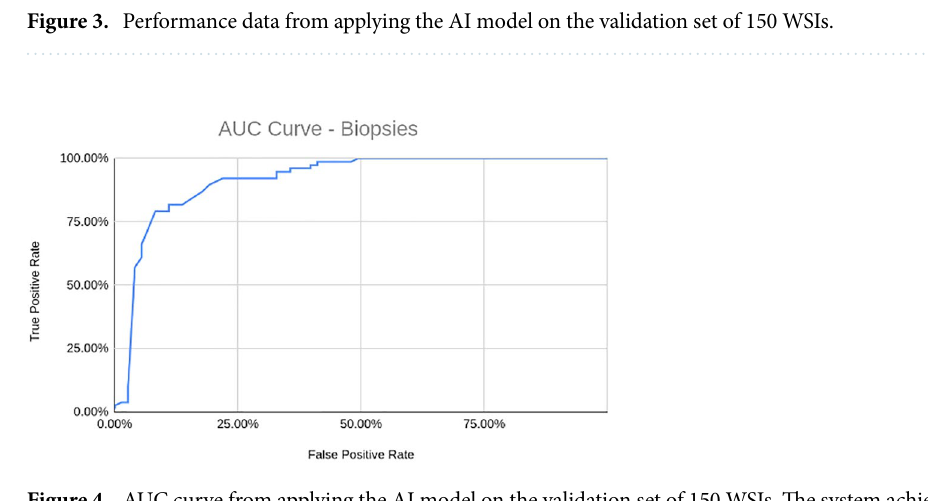
Figure 4. AUC curve from applying the AI model on the validation set of 150 WSIs. The system achieves an AUC of